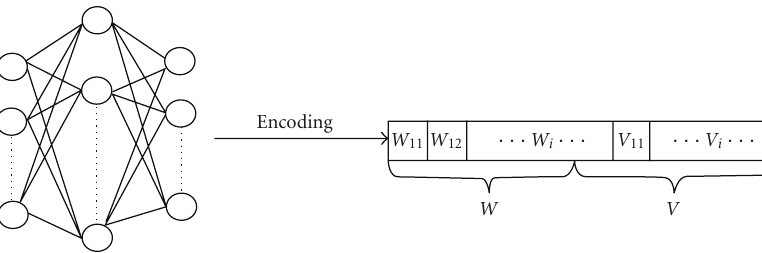
Figure 10: Encoding of the weight values into a string. W : weight matrix from input layer to hidden layer, V : weight matrix from hidden layer to output